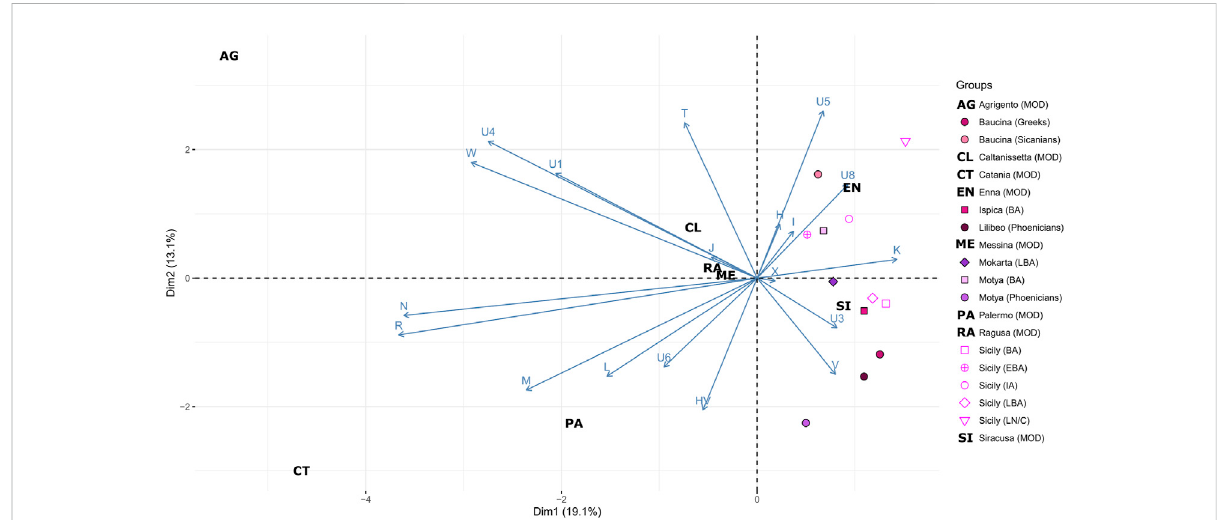
FIGURE 5 MitochondrialgeneticstructureofancientandmodernSicily.PrincipalComponentAnalysis(PCA)onthehaplogroupfrequencieswithinSicilian groupsincludingcontemporarypopulations.Geographicalancientpopulationsareindicatedwithdifferentcolors,whilemodernpopulations(MOD) are indicated with letters. Cultural information of the ancient population is represented using distinct symbols and labelled as follow: LN/C= Late Neolithic/Chalcolithic, BA = Bronze Age, EBA = Early Bronze Age, LBA = Late Bronze Age, IA = Iron Age, PE =